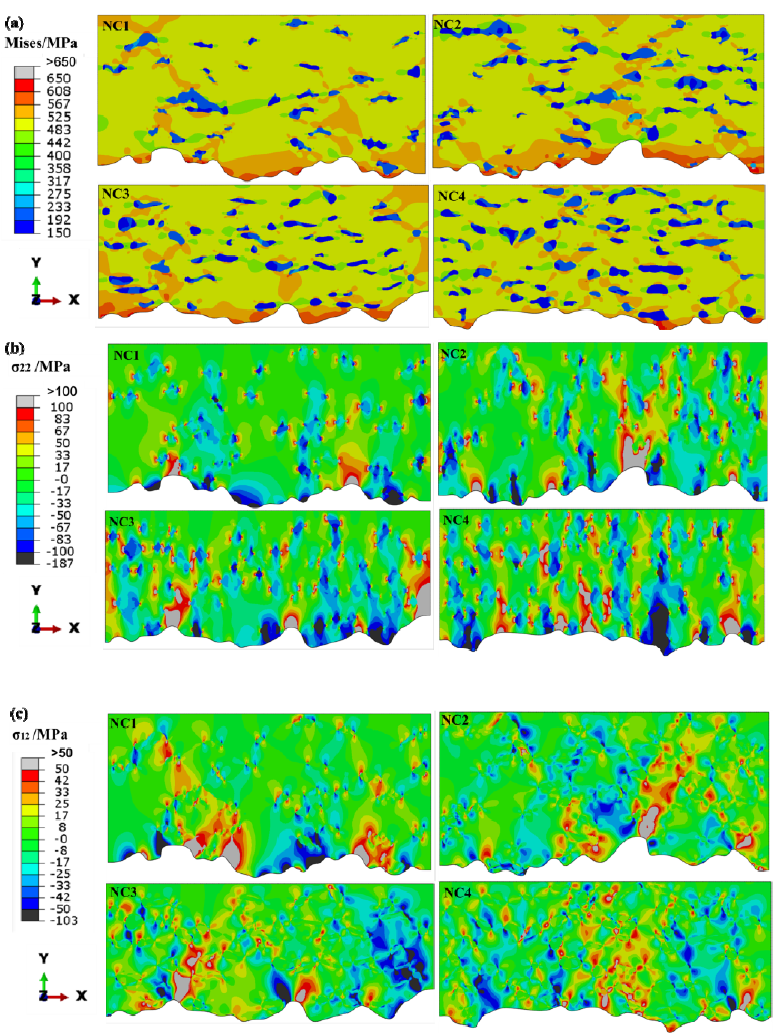
Figure 4. ( a ) Misses stress; ( b ) σ 22 and ( c ) σ 12 stress distribution of top coats in NC1, NC2, NC3 and NC4.